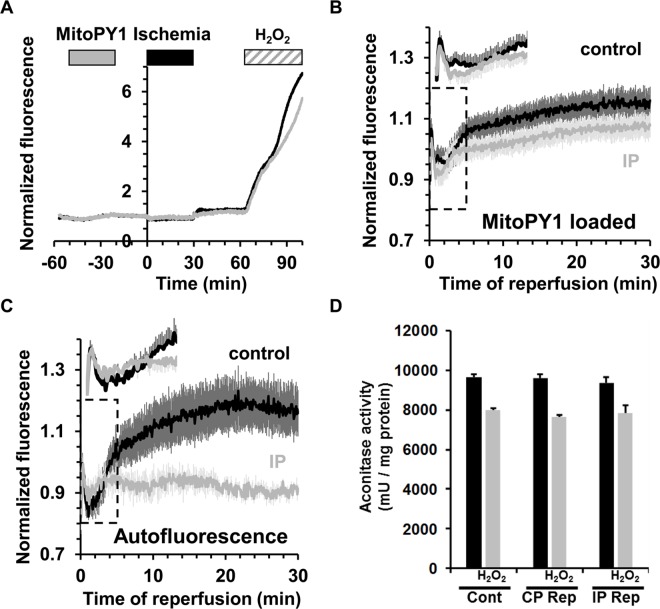
Measurement of mitochondrial H2O2 following ischemia / reperfusion in the perfused heart using MitoPY1 and aconitase activity.A, MitoPY1 fluorescence (535 nm) in control (black) and IP (grey) in Langendorff-perfused hearts subjected to 30 min ischemia + 30 min reperfusion. Fluorescence was normalized to the 1 min pre-iscaemic value. MitoPY1 was successfully loaded into the hearts as shown by the increase in fluorescence upon addition of H2O2 to the perfusion medium. B, Mean 535 nm fluorescence (± SEM as error bars) was normalized to the average value between 20.5 and 21.5 min obtained on reperfusion after 30 min global ischemia in control (black, n = 10) and IP hearts (grey, n = 8). C, Corresponding autofluorescence data for hearts subject to a mock loading protocol (n = 6 in both control and IP hearts). Corresponding infarct sizes are presented in Table 1. D, Aconitase activity in mitochondria isolated from normoxic control hearts (Cont) and both control (CP Rep) and ischemic preconditioned (IP Rep) hearts subjected to 30 min ischemia and 90 s reperfusion as described in S1 Fig The grey bars confirm the reduction in aconitase activity following treatment of the mitochondrial extract with 200 μmol/L H2O2. Data are given as means ± SEM (error bars) of 4 hearts in each group.